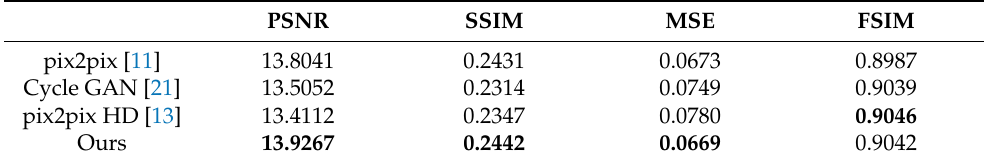
Table 4. Comparison of the indexes between the images generated by four methods and the SEN-2 images. The number in bold indicates the optimal value under the corresponding